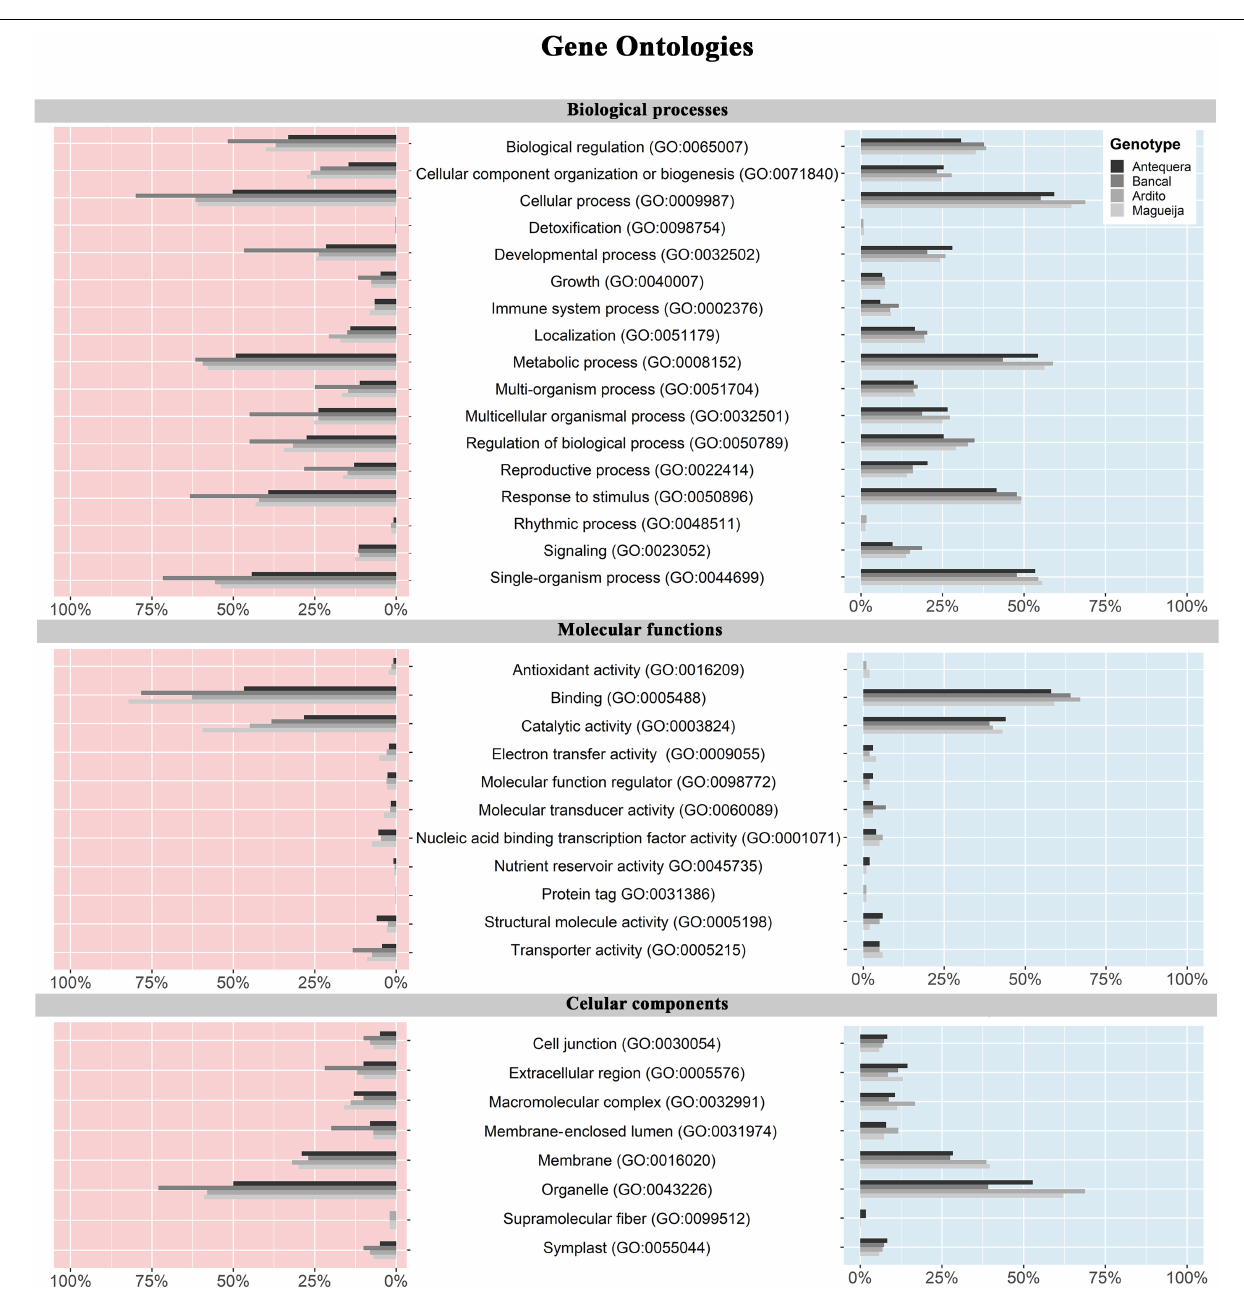
FIGURE 3 | Gene ontology percentage of up and downregulated genes in commercial varieties Antequera and Bancal and landraces Ardito and Magueija assigned to second and third levels of biological processes, molecular functions and cellular component gene ontologies. Red and blue indicate down and upregulated genes,